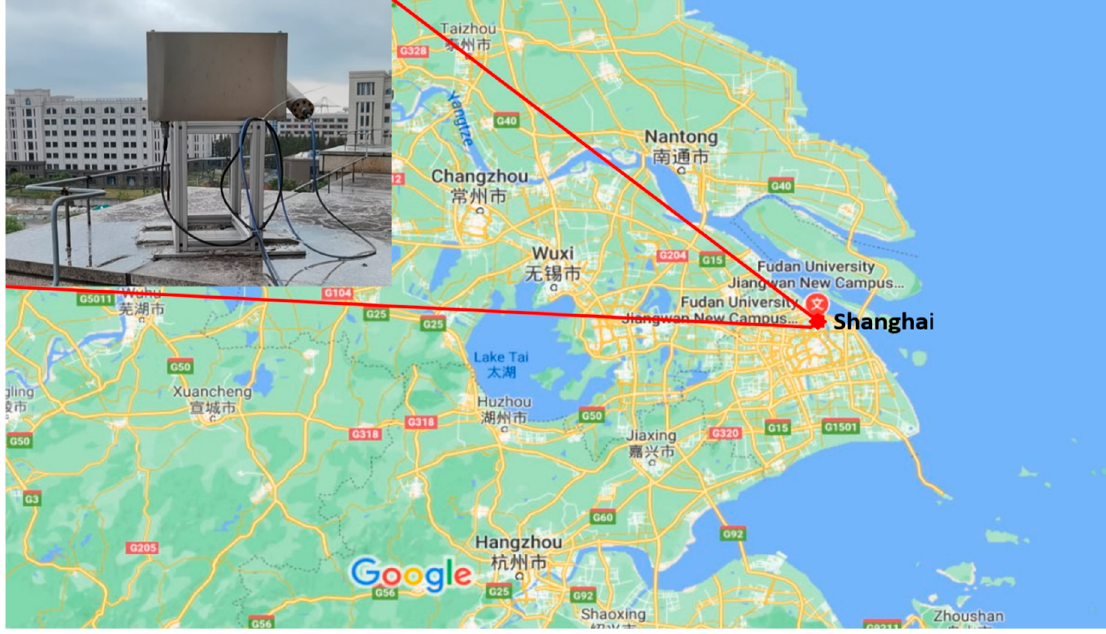
Figure 1. Multi-axis differential optical absorption spectroscope (MAX-DOAS) observation site at Fudan University, Yangpu District, Shanghai (Map Source: Google Map).